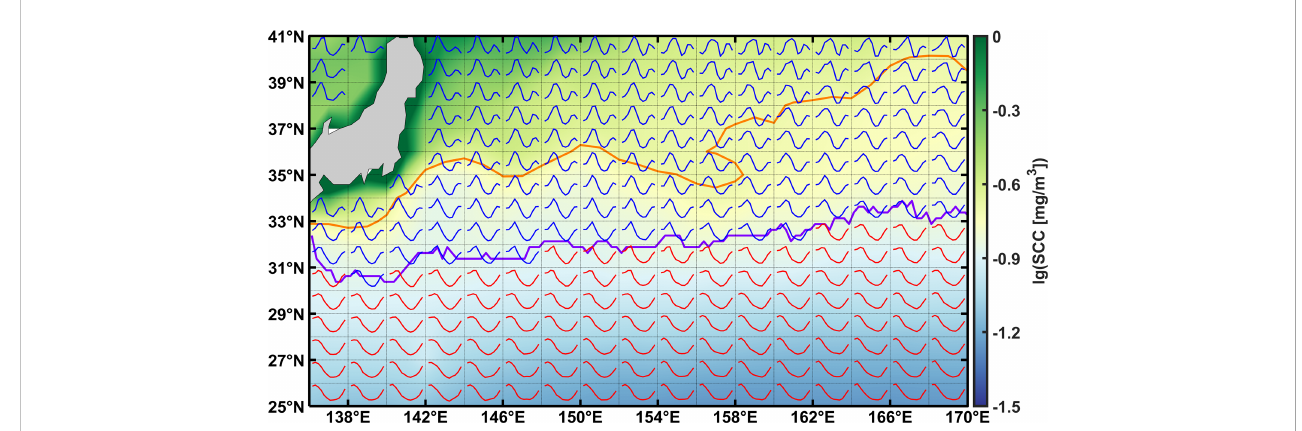
FIGURE 1 The standardized seasonal cycle of SCC in the KE region. The seasonal cycles of SCC, derived from the monthly averaged data from 2003 to 2018, are plotted within a bin of 2×1°. Colored shadings represent the multi-year-averaged SCC, and the transition zone (i.e., 0.2 mg/m 3 contour) is denoted as the bold orange line. The unimodality and bimodality of SCC are indicated by red and blue lines, respectively, and the boundary of them as the bold purple